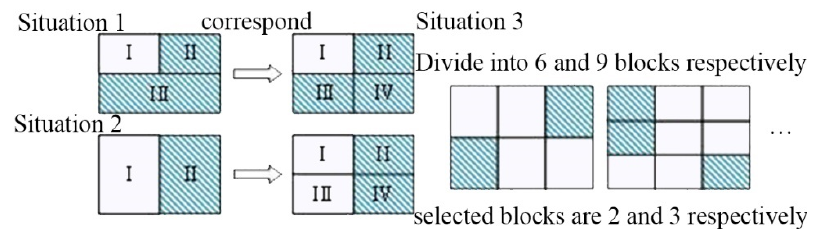
Figure 3. Special cases in image block.